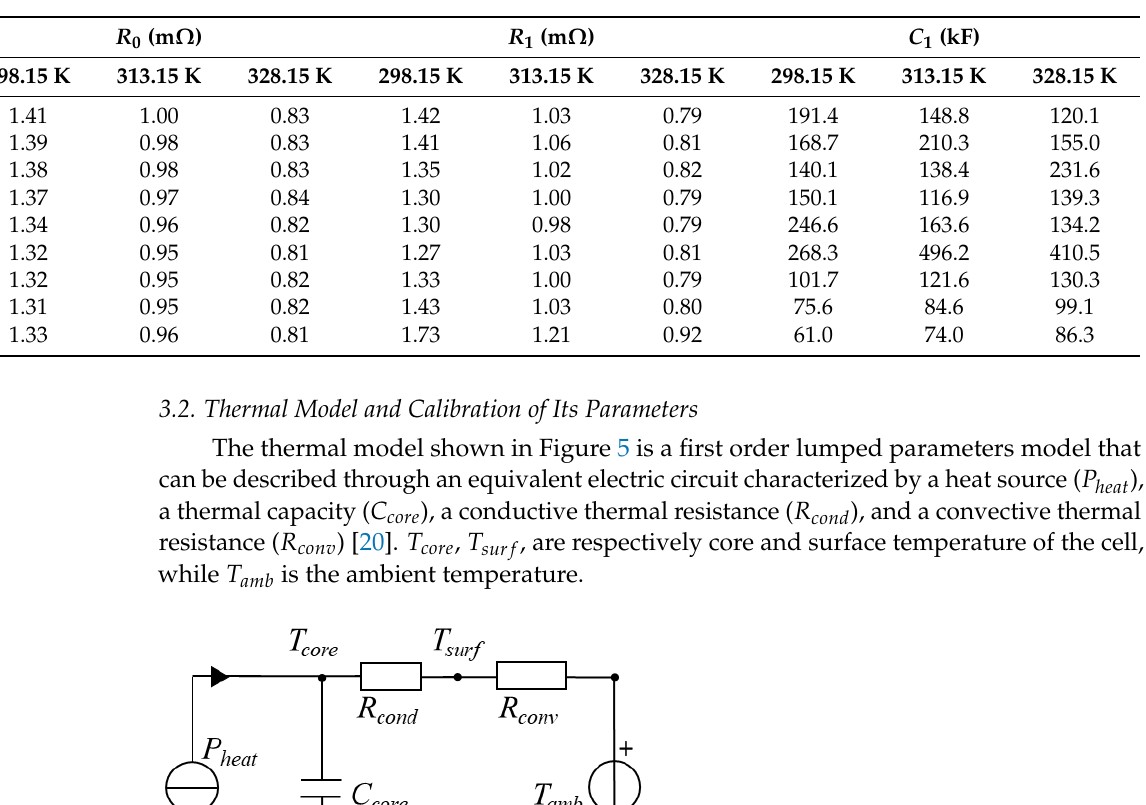
Figure 4. Example of a generic charge step in an MST test. Table 3. Electrical model parameters. Table 3. Electrical model parameters.